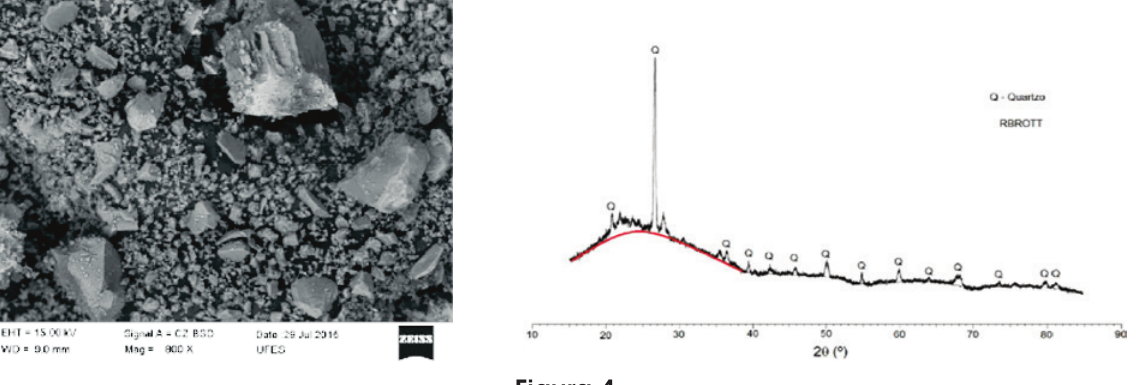
Difratograma de raios X do